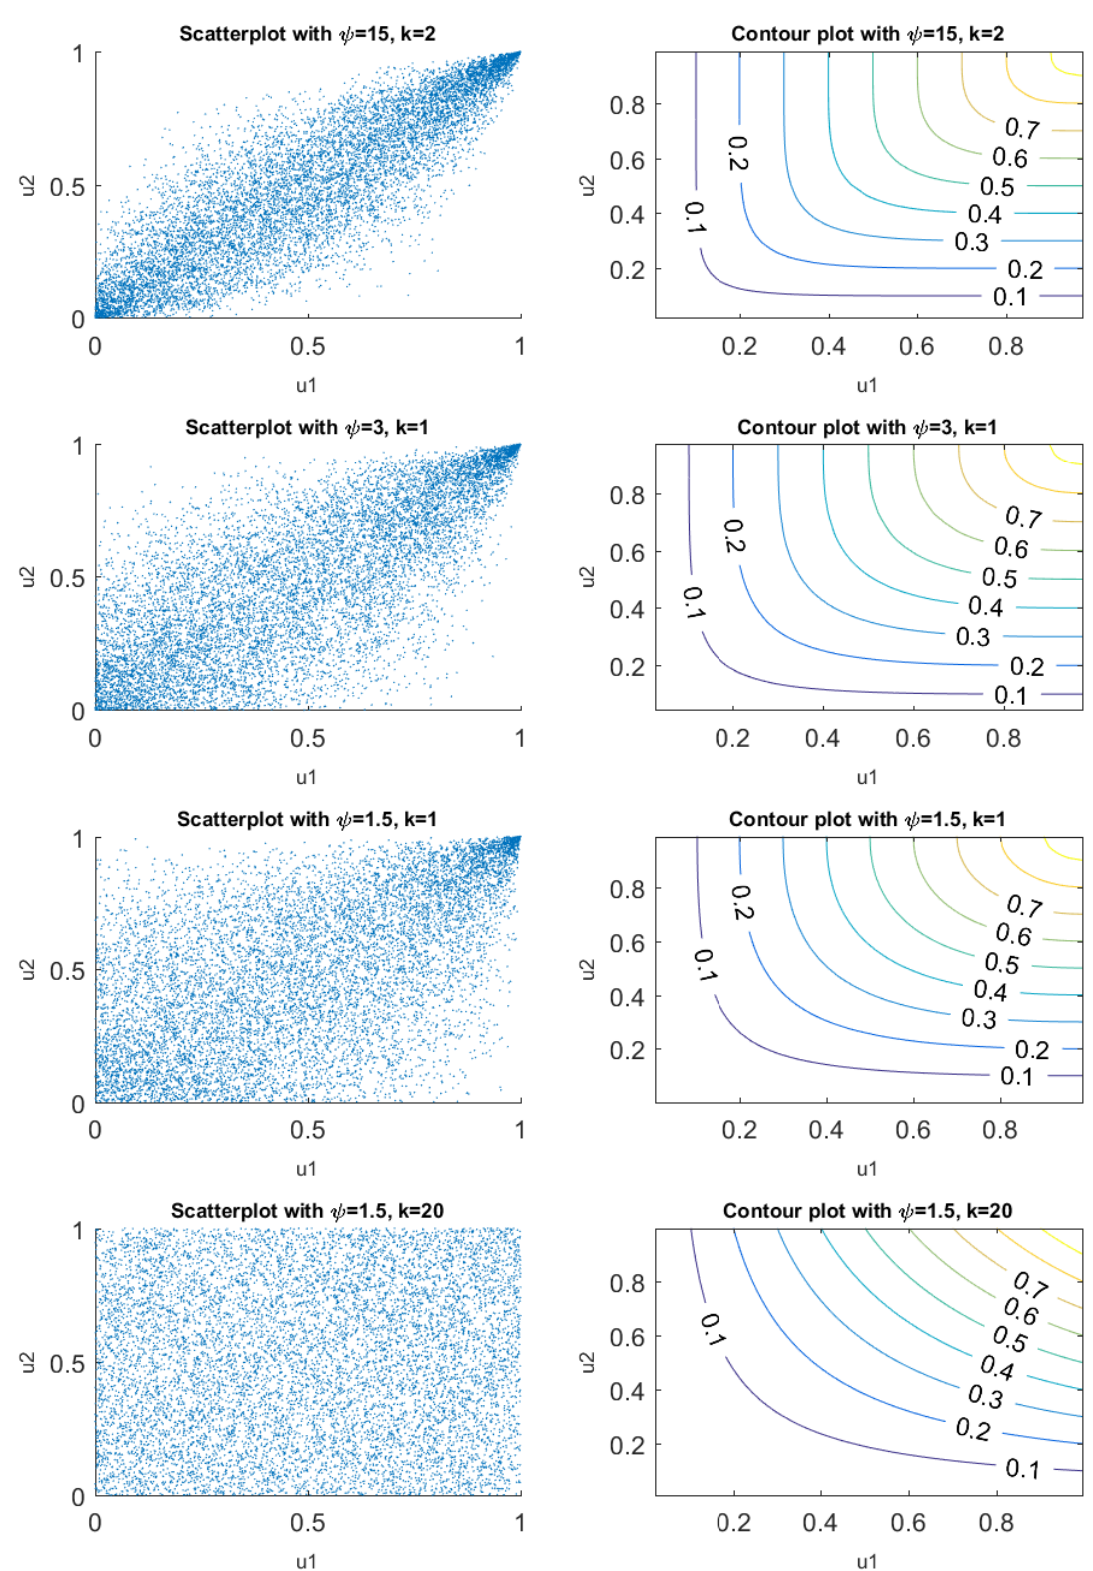
Figure 1: Contours and scatterplots of bivariate GB2 copula with various